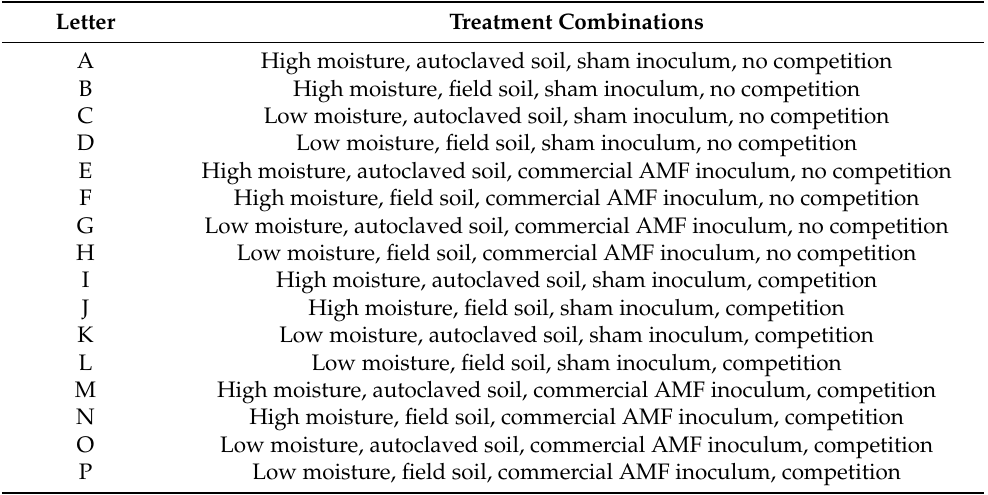
Table 1. Different combinations of 16 treatments (high-low moisture, autoclaved-field soils, sham- AMF inoculum, no-yes competition) used in the